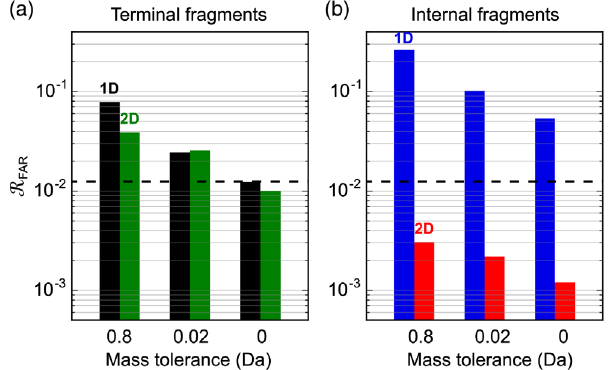
FIG. 5. Ambiguity of peptide fragment identification in the 1D and 2D techniques compared by a numerical simulation. Peptides of a given mass are selected from a protein database within the 7-ppm mass tolerance and fragmented according to known fragmentation rules. The resulting individual fragment ion m=z (in 1D) and correlated pairs of m=z (in 2D-PC-MS) are tested for uniqueness among the database peptides within the given frag- ment mass-matching tolerance, and any ambiguity is counted toward the average relative FAR of the given type of fragments (terminal or internal). While the 2D and 1D MS perform comparably for the terminal fragments [panel (a)], there is a dramatic reduction in identification ambiguity (note the loga- rithmic scale) when looking at the internal fragments [panel (b)]. In fact, the ambiguity rate for 2D signals involving internal fragments, even at a modest 0.8-Da tolerance, drops well below the theoretical lowest limit (0-Da tolerance) of the 1D technique for any fragment type (horizontal dashed